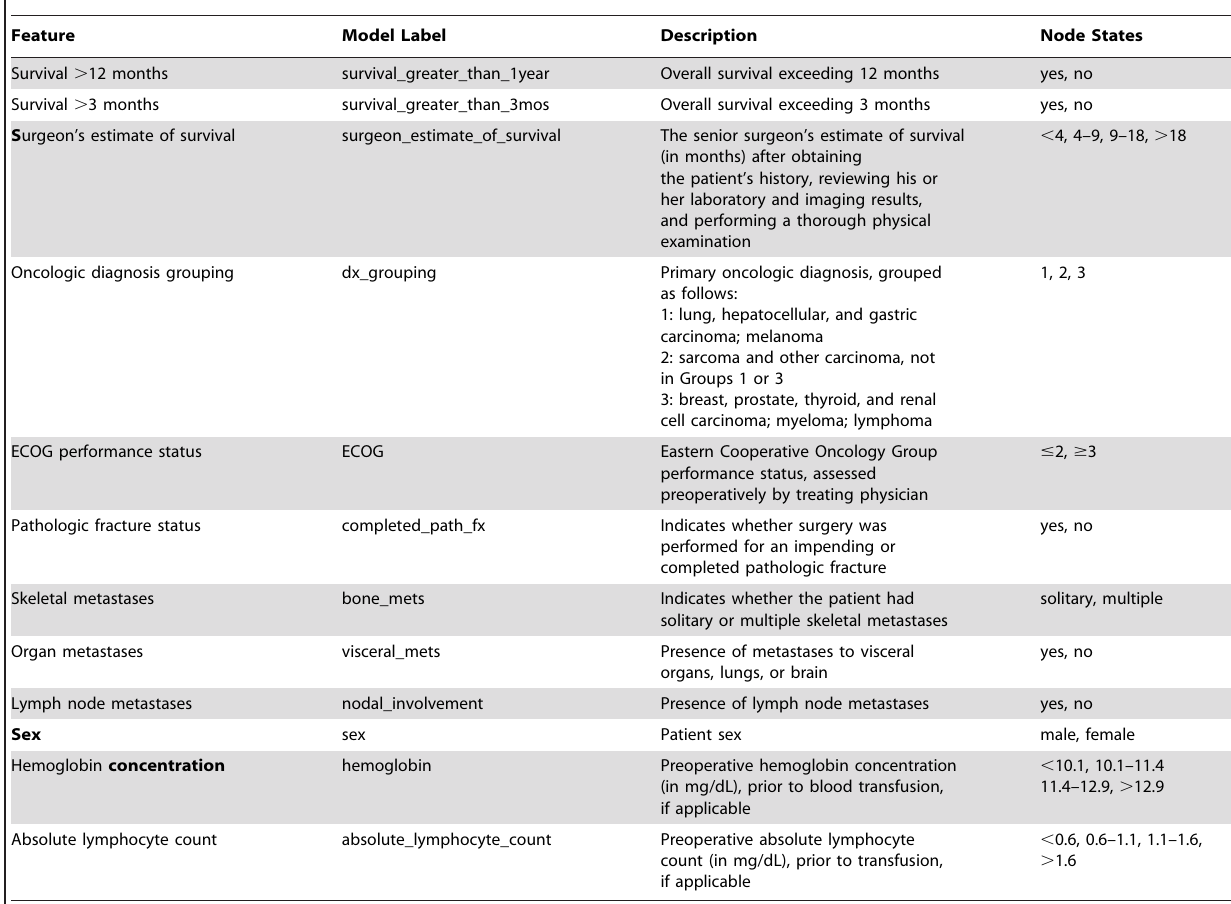
Table 1. Network features used in the final BBN